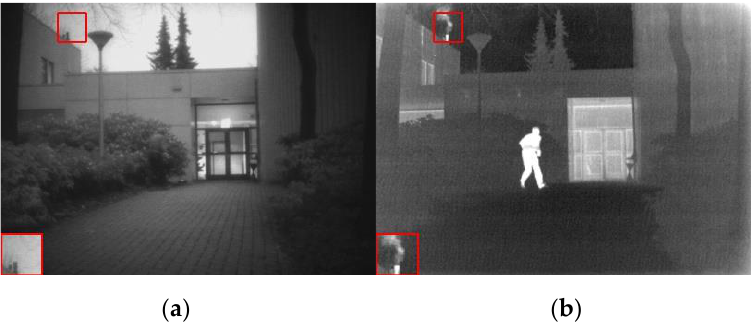
Figure 6. The loss function compares the experimental source data, ( a ) Visible image, ( b ) Infrared image.